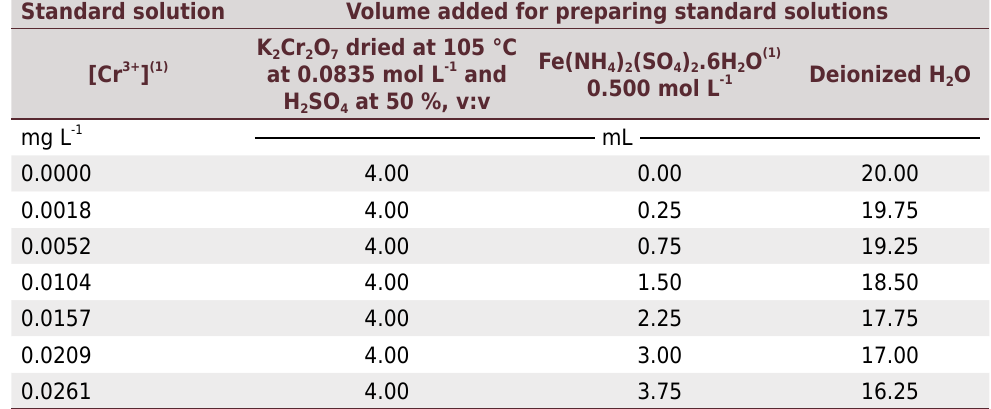
Table 1. Preparation conditions of standard solutions used in the calibration curve of the spectrophotometric method alternative to the Embrapa